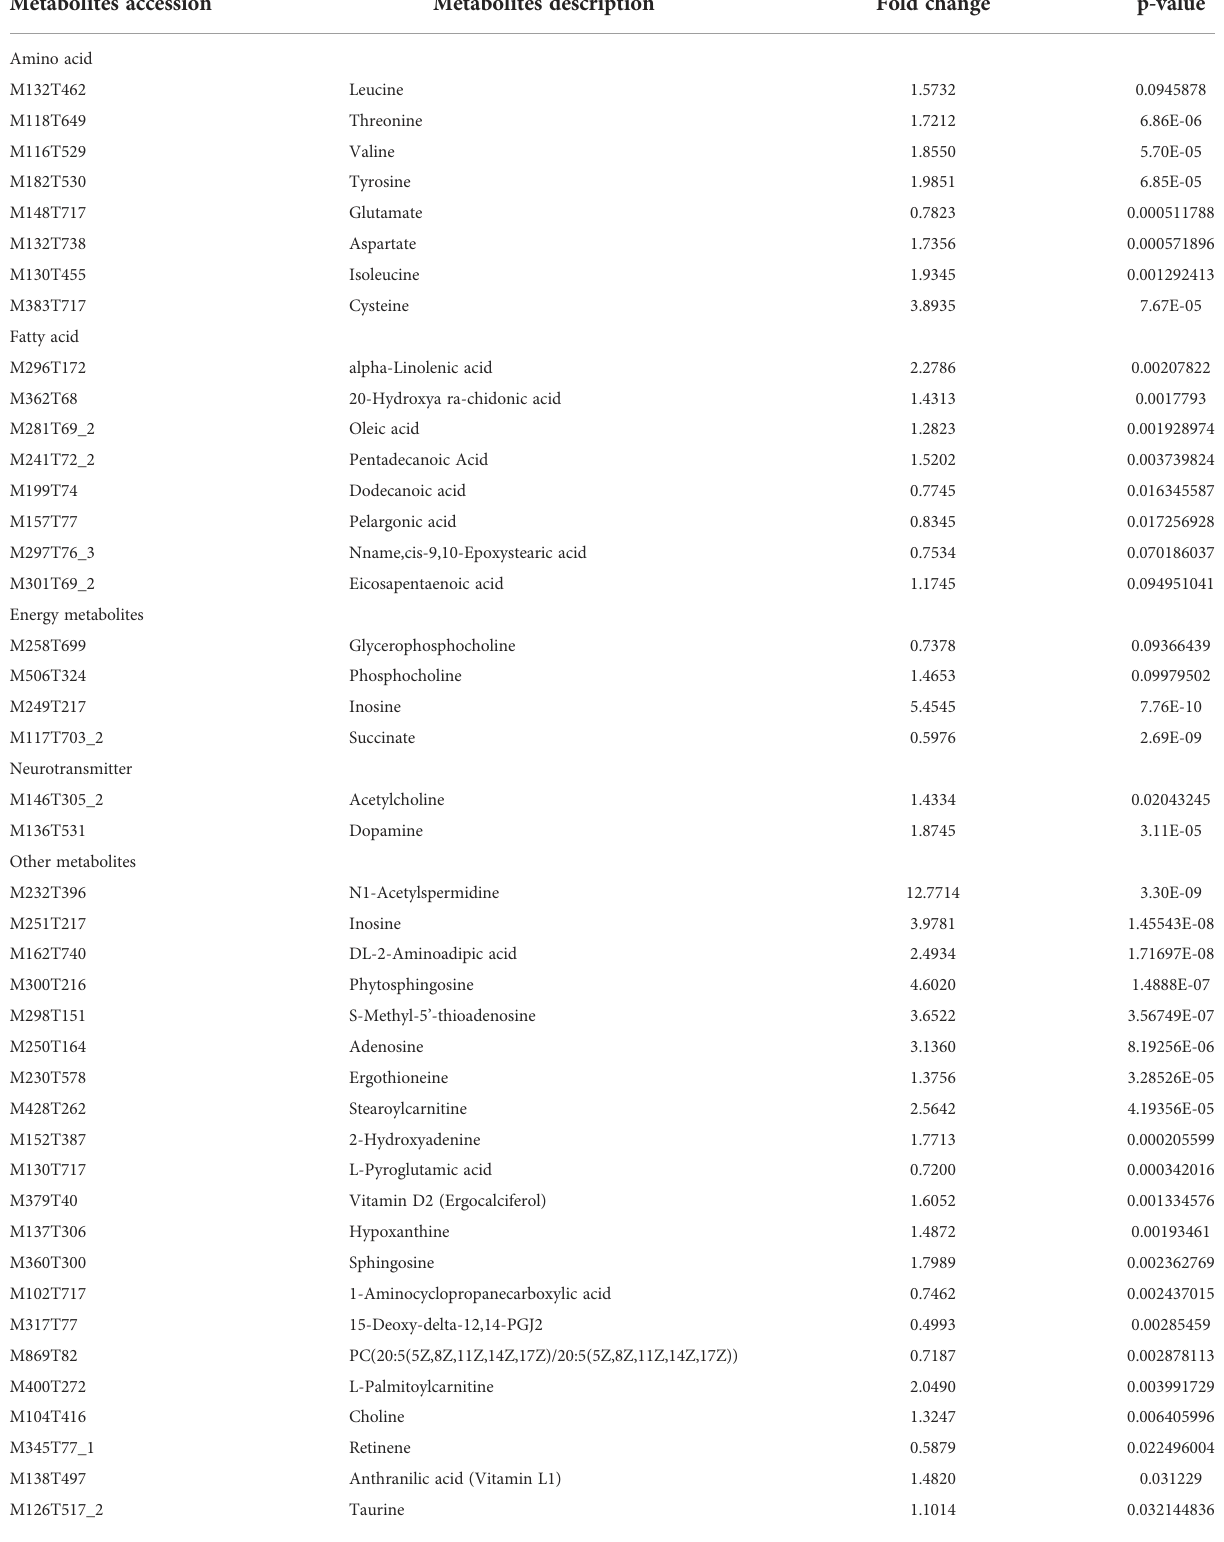
TABLE 2 The details of some differential metabolites in A. japonicus after SMC